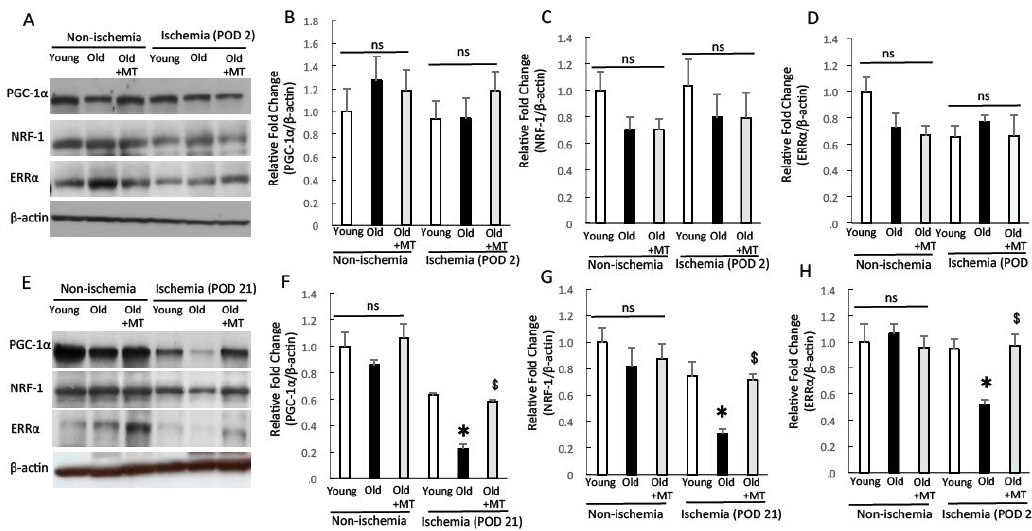
Figure 7. The protein expressions of peroxisome proliferator-activated receptor γ coactivator-1 α (PGC-1 α ), nuclear respiratory factor (NRF)-1 and estrogen-related receptor α (ERR α ). The expression of PGC-1 α , NRF-1 and ERR α was analyzed by Western blotting in the non-ischemic and ischemic (POD 2 and 21) skeletal muscles of young, old, and MitoTEMPO-treated old mice. Representative images of PGC-1 α , NRF-1 and ERR α for POD 2 ( A ) and POD 21 ( E ) and the summarized findings after quantification of PGC-1 α / β -actin (( B , F ) POD 2, 21, respectively), NRF-1/ β -actin (( C , G ) POD 2, 21, respectively) and ERR α / β -actin (( D , H ) POD 2, 21, respectively). For POD 2, the expression of PGC-1 α , NRF-1 and ERR α did not differ among the three groups. For POD 21, the expression of PGC-1 α , NRF-1 and ERR α was lower in old mice than young mice. MitoTEMPO treatment effectively preserved PGC-1 α , NRF-1 and ERR α expression to similar levels as young mice. MT indicates MitoTEMPO. The values are expressed as the means ± S.E.M. n = 10, each. * p < 0.05 vs. young mice, $ p < 0.05 vs. old mice. ns indicates no significant difference.